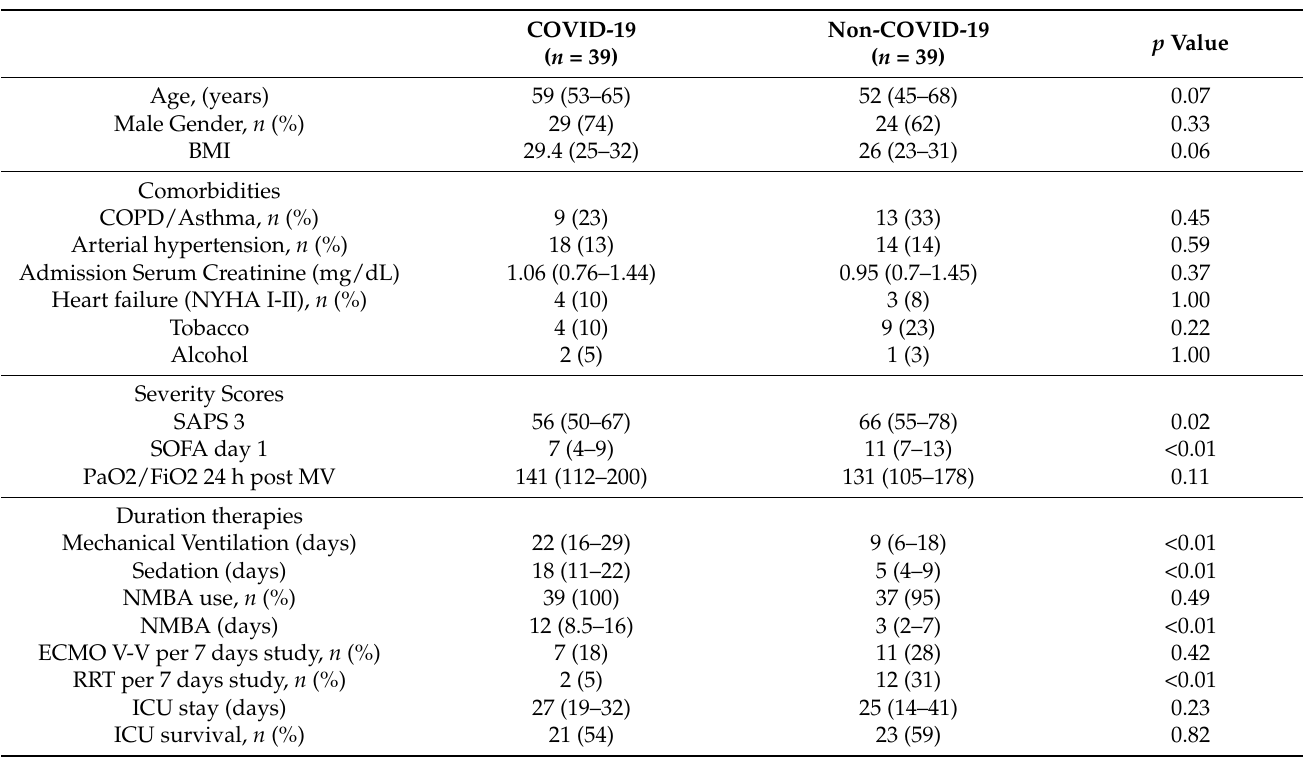
Table 2. Characteristics of the study cohorts. Data are expressed as counts (percentage) and median (interquartile range). Legend: BMI = Body Mass Index; COPD = Chronic obstructive pulmonary disease; NYHA = New York Heart Association score; SAPS 3 = Simplified acute physiology score; SOFA = Sepsis-related Organ Failure; MV = Mechanical Ventilation; NMBA = Neuromuscular blocking agents; ECMO = Extracorporeal membrane oxygenation; RRT = Renal replacement